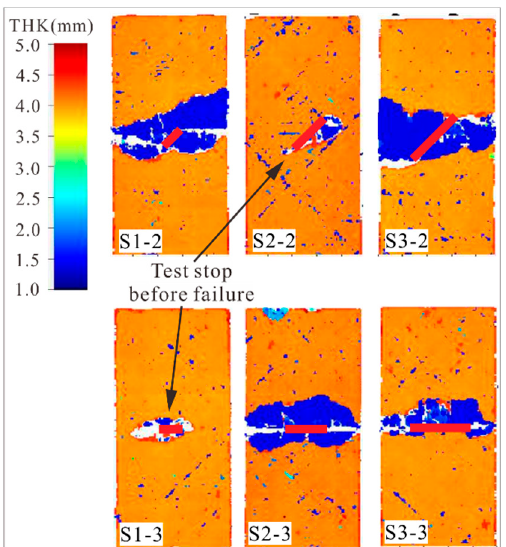
Figure 11. Delamination in specimens with shallow surface cracks after compression failure. When the crack depth increased to 40% of the thickness, the initiation strain of 45° cracks was between 6493 με and 7188 με , which gradually decreased with the increase of crack length, as shown in Figure 12a. All the cracks propagated to the specimen sides in a few frames, which implies the instability of crack propagation. Obvious extrusion and dislocation of surface plies were observed during the crack propagation process. Figure 12b shows the crack growth in specimens with 90° cracks. The initial strain corresponding to the crack propagation decreased gradually with the increase of crack length, and the corresponding strain range was 5203–6741 με . Similar to shallow surface cracks, a stable crack growth process was found, the crack tip did not propagate with the load increase after initiation. After that, the crack rapidly propagated to the side of laminates, resulting in the failure of the specimen.